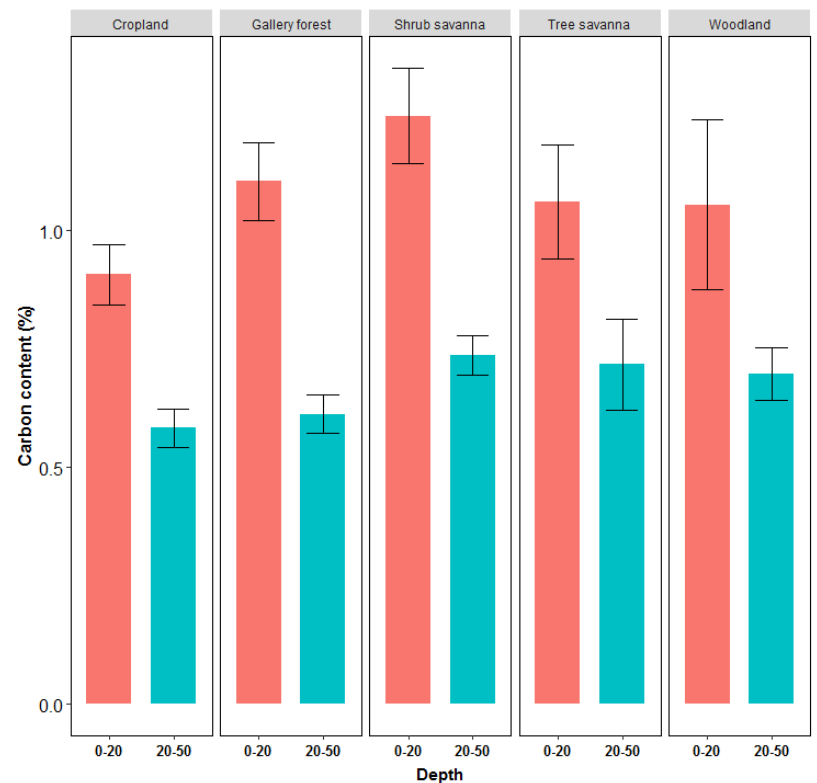
Figure 4. Variation of soil organic carbon in top and subsoil across different land use and land cover categories (LULCc).